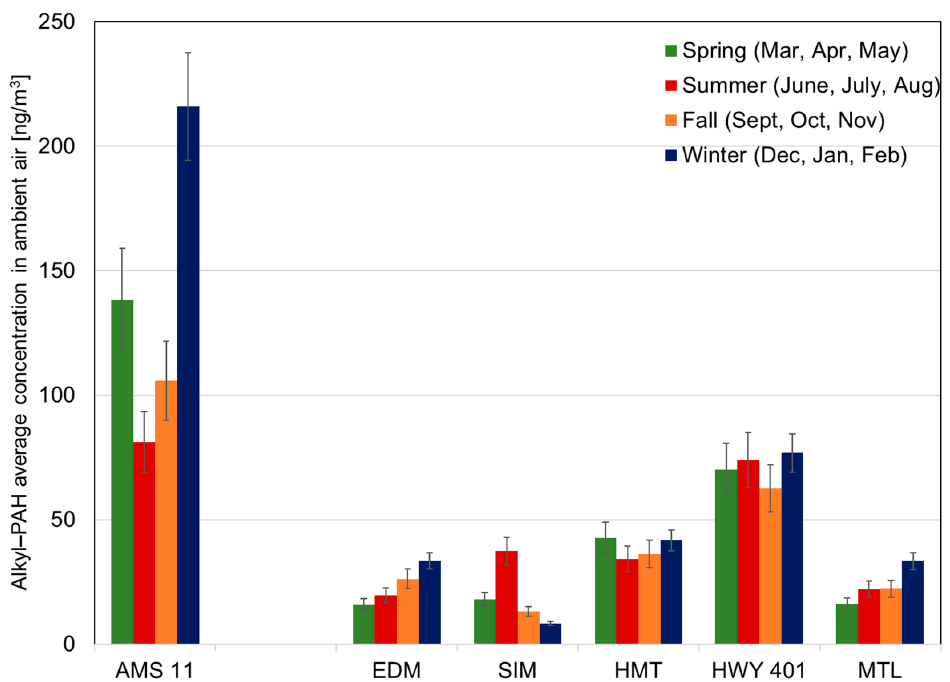
Figure 4. Seasonality effects of alkyl-PAH by site for 2015–2016 period; the data from the AMS11 site are reported for comparison [16].